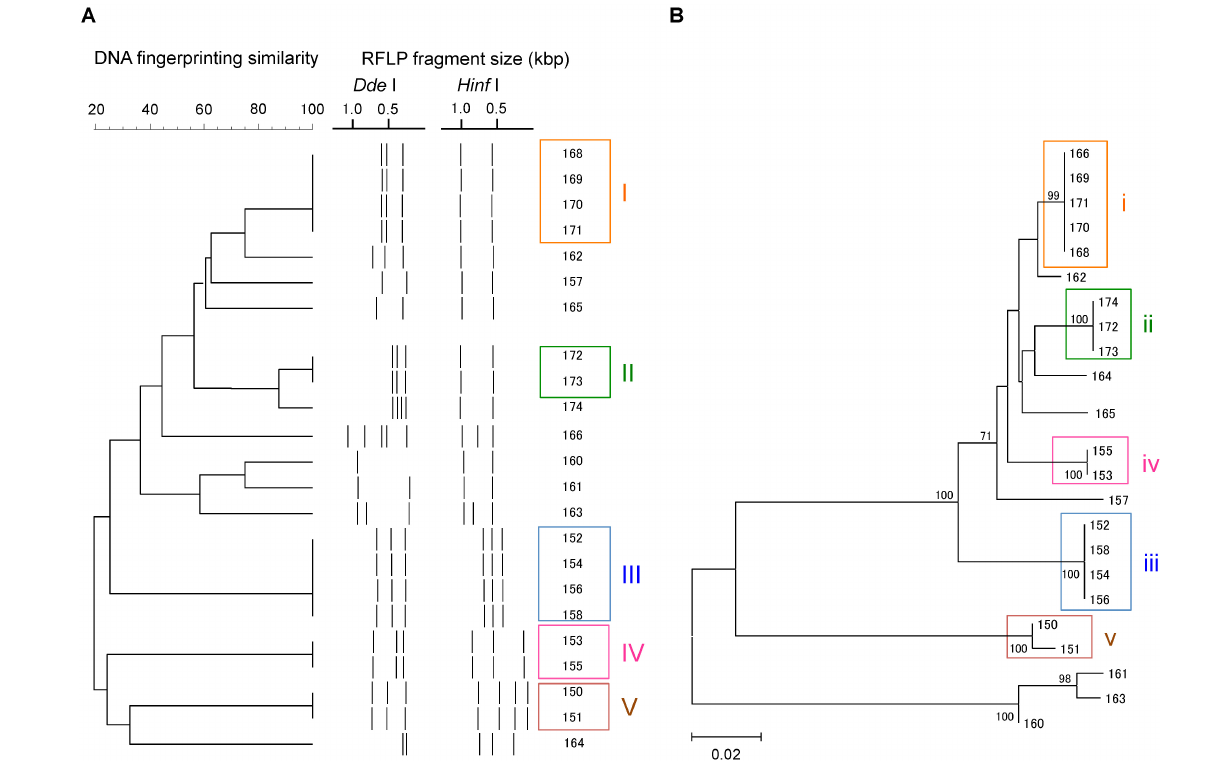
Frontiers in Microbiology |